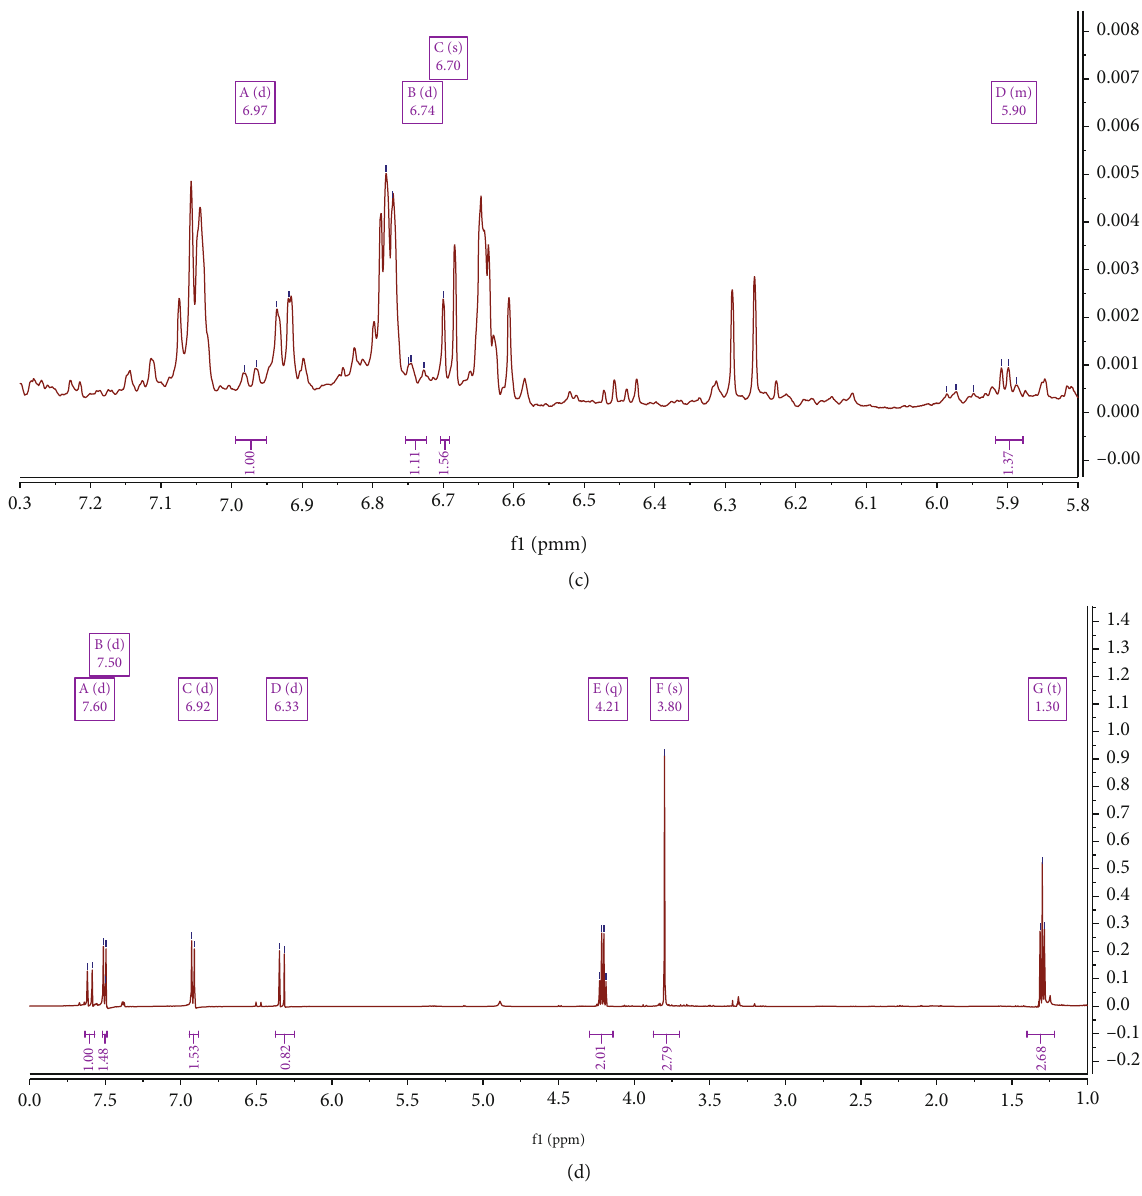
Figure 4: 1 H-NMR pro fi le of A. graveolens with chemical shift of apiin (a), E. elatior with chemical shift of ca ff eic acid (b), O. xcitriodorum with chemical shift of eugenol (c), and K. galanga with chemical shift of ethyl p-methoxycinnamate